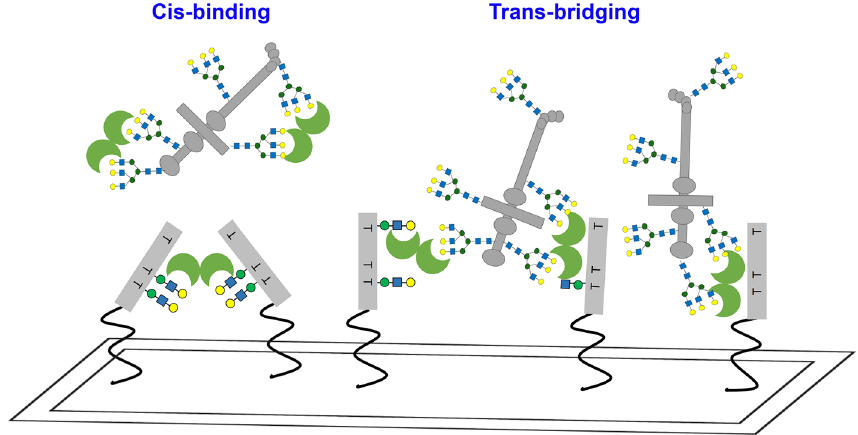
Figure 9. The cis -binding and trans - bridging activities of Gal-1 with α-DG core M1 glycoconjugates and laminin in